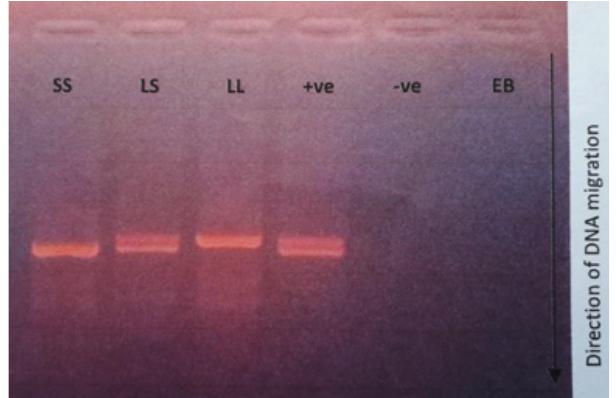
Figure 1. Agarose gel with DNA bands of the different genotypes (SS, LS and LL), positive control, negative control and extraction blank (EB) respectively. The lighter short DNA migrates further down than the heavier long one.